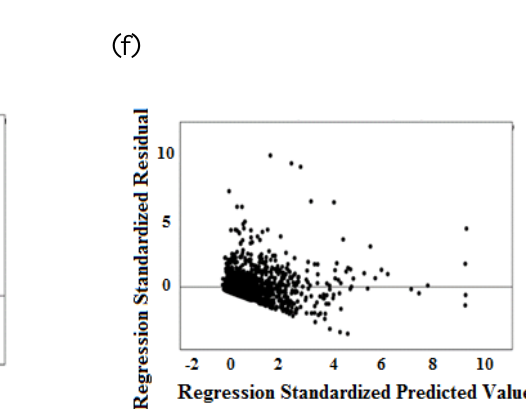
Figure 2. ( a ) Standardized residual analysis of PM 10,t+1 , ( b ) standardized residual analysis of PM 10,t+2 , ( c ) standardized residual analysis of PM 10,t+3 , ( d ) testing assumption of variance and uncorrelated with mean equal to zero for model PM 10,t+1 , ( e ) testing assumption of variance and uncorrelated with mean equal to zero for model PM 10,t+2 , ( f ) testing assumption of variance and uncorrelated with mean equal to zero for model PM